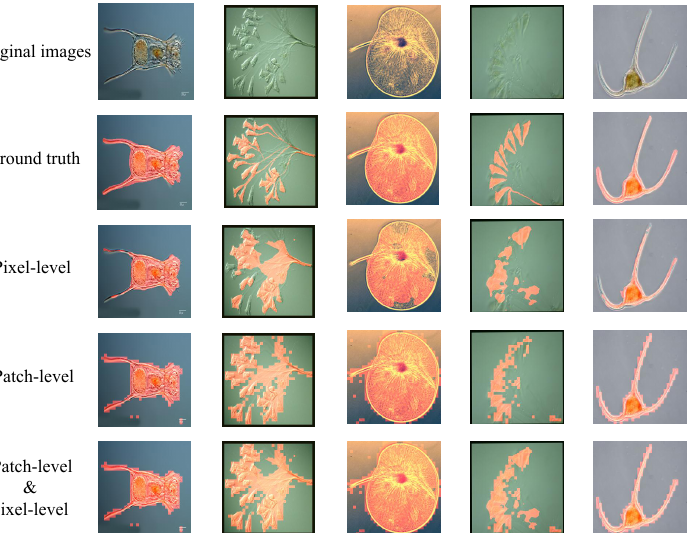
Figure 14. Valid examples in EMDS-5 that fuse pixel-level segmentation and patch-level segmentation. From top to bottom, the images in each original image of EM, the EM represent GT image, pixel-level segmentation result, patch-level segmentation result, and combined result, respectively. (The red part in the figure is the segmentation